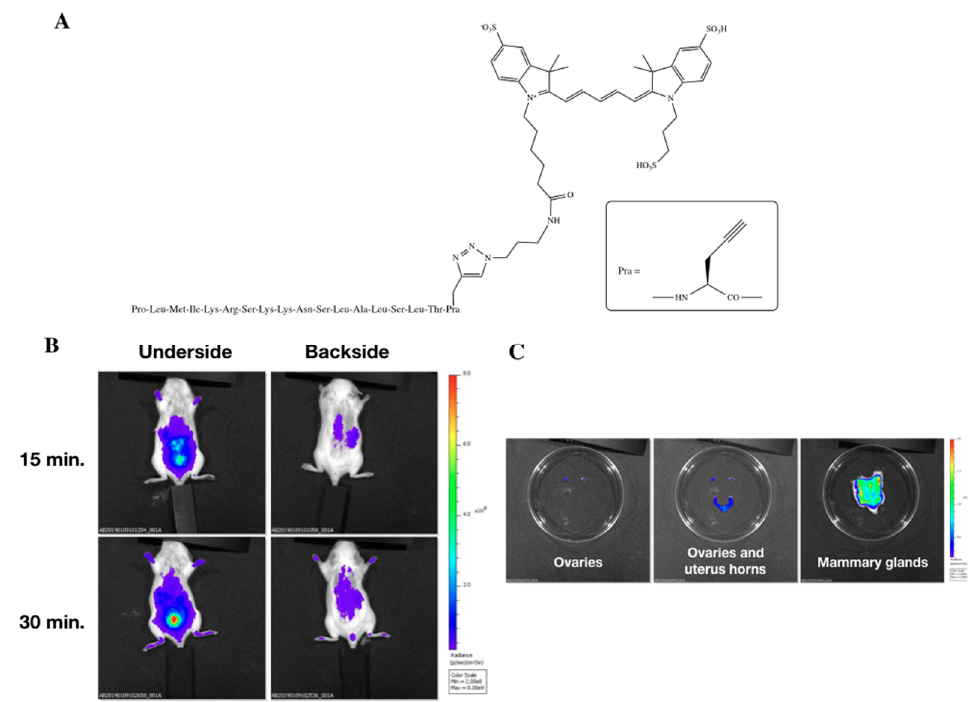
Figure 6. Distribution in mice of the peptide ER α 17p at a dose of 2 mg / kg. ( A ) Structure of the Cy5-labeled peptide. ( B ) Pharmacokinetics of the Cy5-labeled peptide after 15 min and 30 min (underside and backside views). ( C ) Distribution of the peptide after 30 min in the ovaries (left), in the ovaries and uterus horns (middle), and in the mammary glands (right).